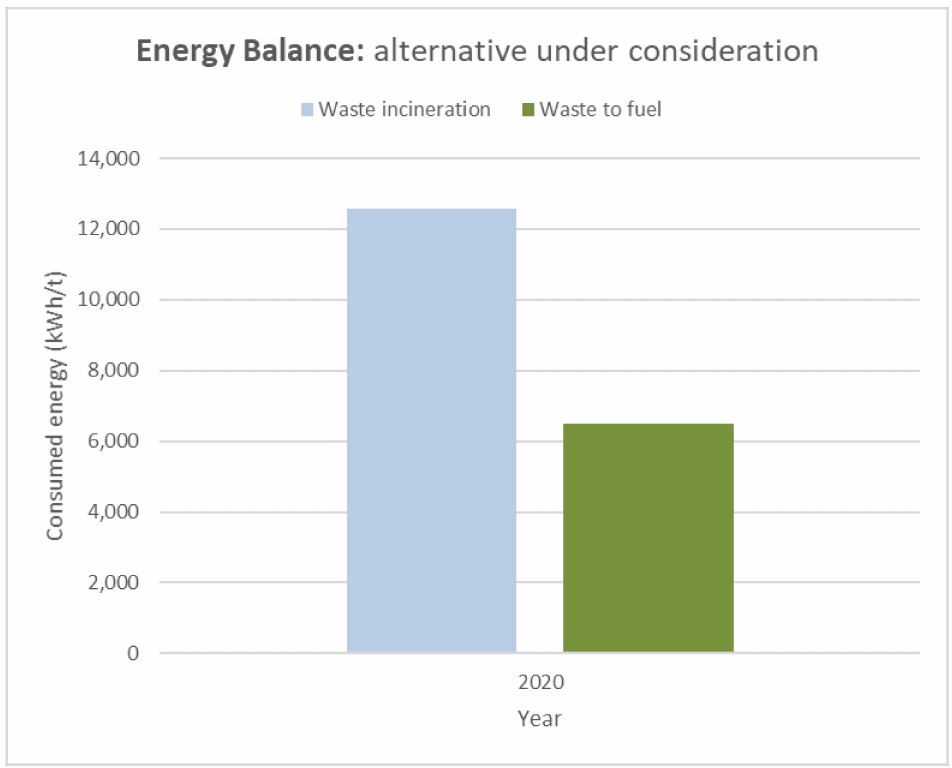
Figure 4. Graphical representation of the two